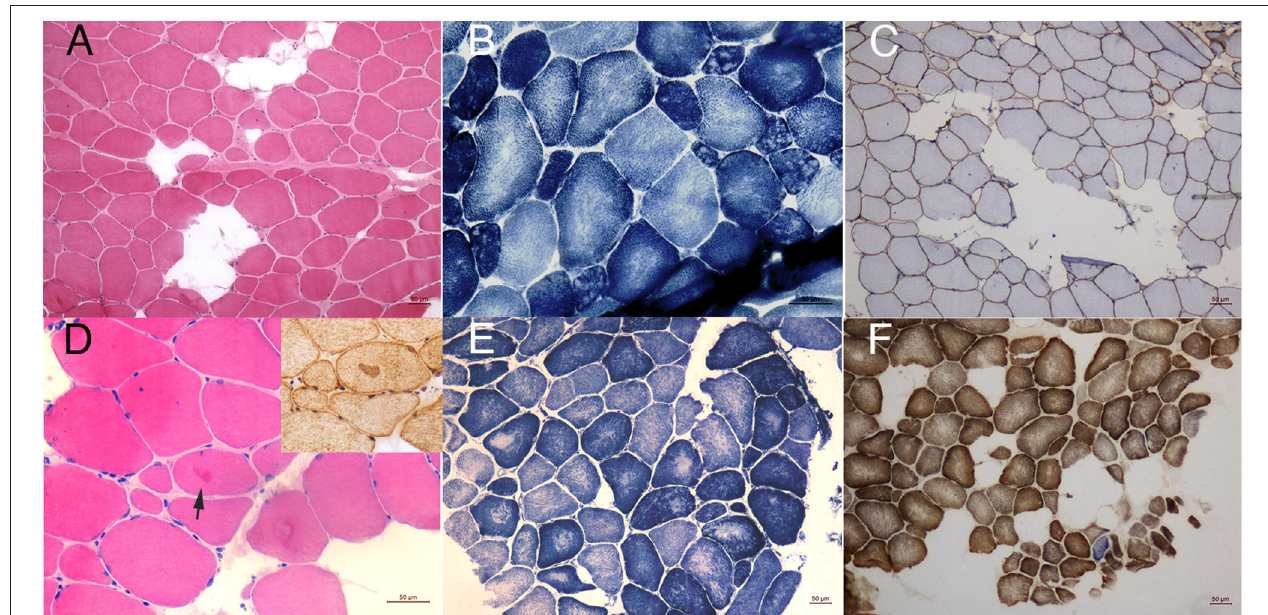
FIGURE 2 | Pathological findings. HE staining of patient one (A) showed mild dystrophy changes with many fibers replaced by adipose tissues. NADH staining (B) revealed focal decrease of oxidative enzyme activities in atrophy fibers compatible of multiminicore lesions. Immunohistochemical staining of dystrophin N was normal (C) . In biopsy of patient four, eosinophilic inclusions could be occasionally seen in HE staining, which was immunoacitve for desmin (D) . His core lesions in NADH staining were relatively large compared to other patients (E) . SDH/COX staining of patient one (F) showed occasionally blue fiber (magnification 10X).